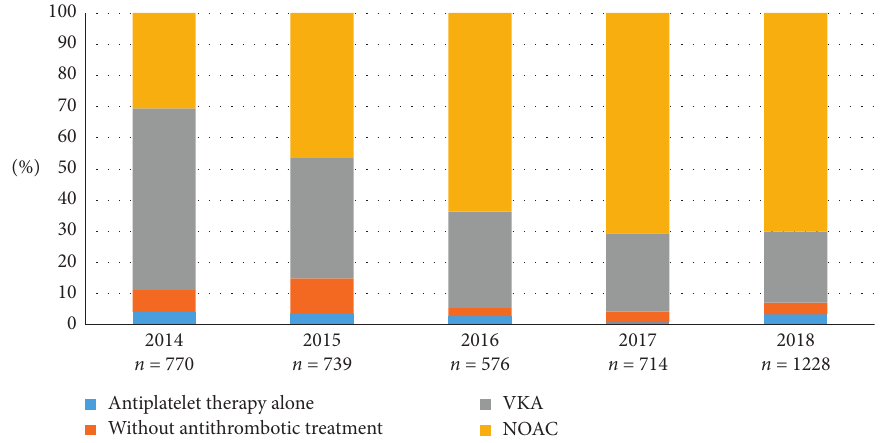
Figure 1: Stroke prophylaxis in patients with atrial fibrillation in particular years of hospitalization.